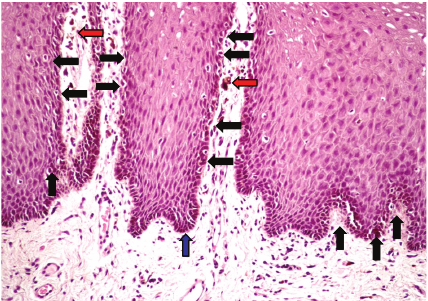
Figure 4: Basal layer pigmentation with increased number of normal melanocytes mostly at chorion epithelial junction in the epithelium (black arrows). Sparse melanophages were noted in the superficial chorion (red arrows), HE X